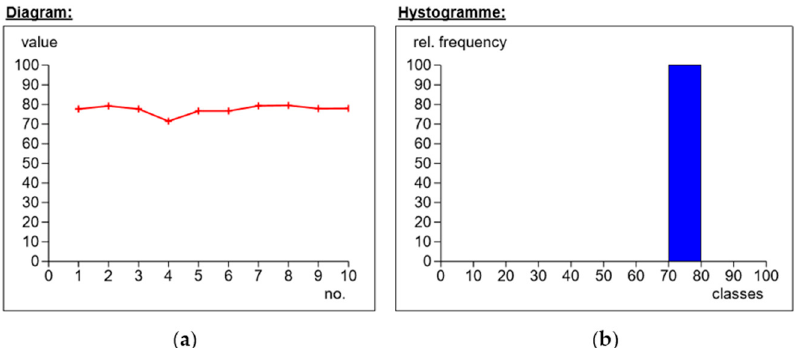
Figure 11. Application of modular fabric IMS65, weave 0/+ 90°, warp MGS L285/H285: ( a ) depend- ence of hardness on the number of measurements; ( b ) percentages of hardness.